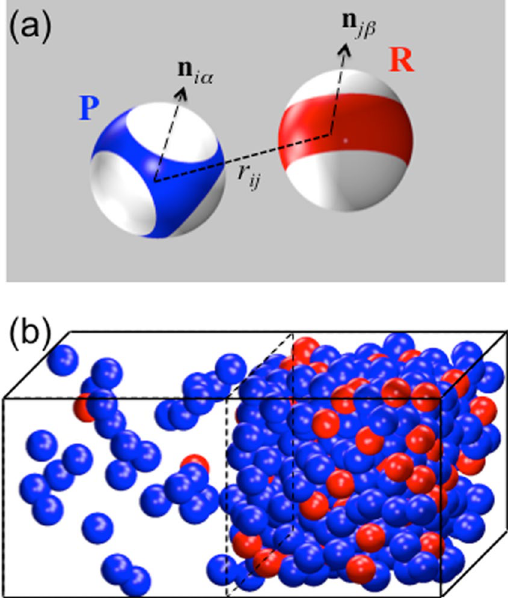
Figure 1. Illustration of the patchy particle model for protein-regulator mixtures and its two phases. ( a ) P and R particles, with cores in blue and red, respectively, and patches in white. ( b ) The low- and high-concentrations phases, after reaching equilibrium in a Gibbs ensemble Monte Carlo simulation. Patches are not